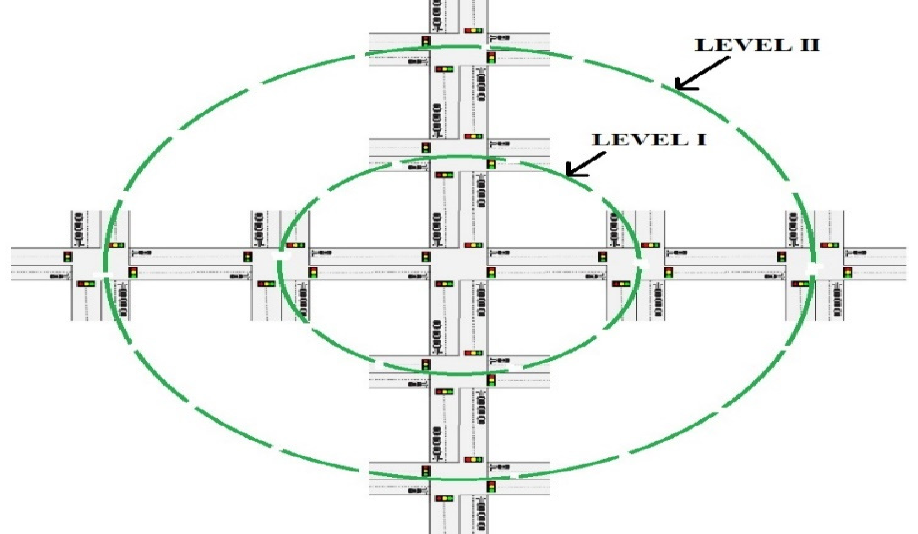
Figure 6. Levels of synchronization.